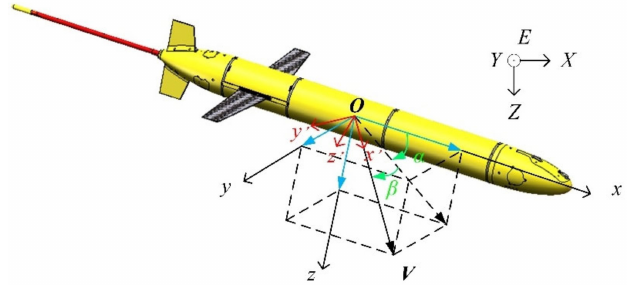
Figure 2. Coordinate frames of